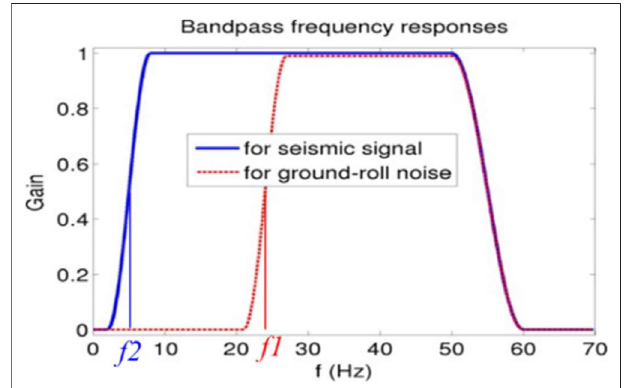
FIGURE 4 | If the input data are likely seismic signals, a bandpass fi lter with low cut-off frequency f 2 is preferable. Otherwise, a bandpass fi lter with a relatively high cut-off frequency f 1 is used to reject the ground-roll noise, of which the spectrum lies below f 1 .